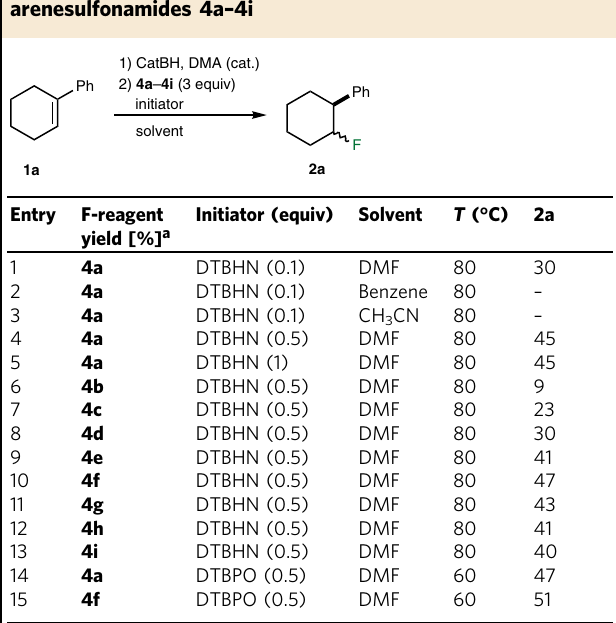
Table 1 Hydro fl uorination of 1a with N - fl uoro- N